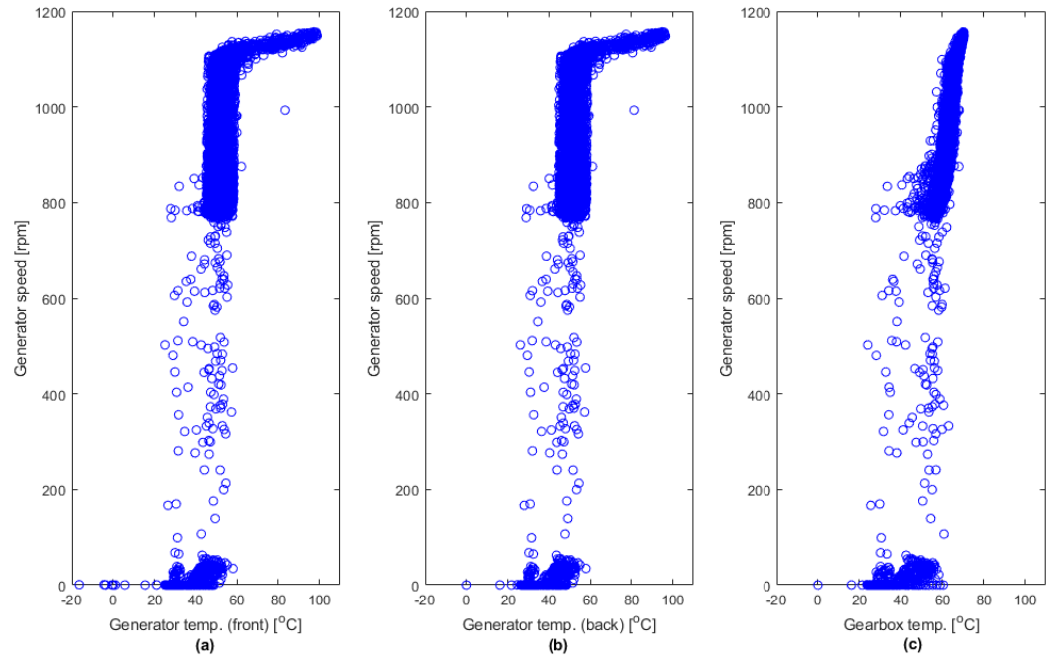
Figure 6. Nonlinear relationships between the generator speed and three temperature parameters: ( a ) generator temperature (front); ( b ) generator temperature (back); and ( c ) gearbox temperature.